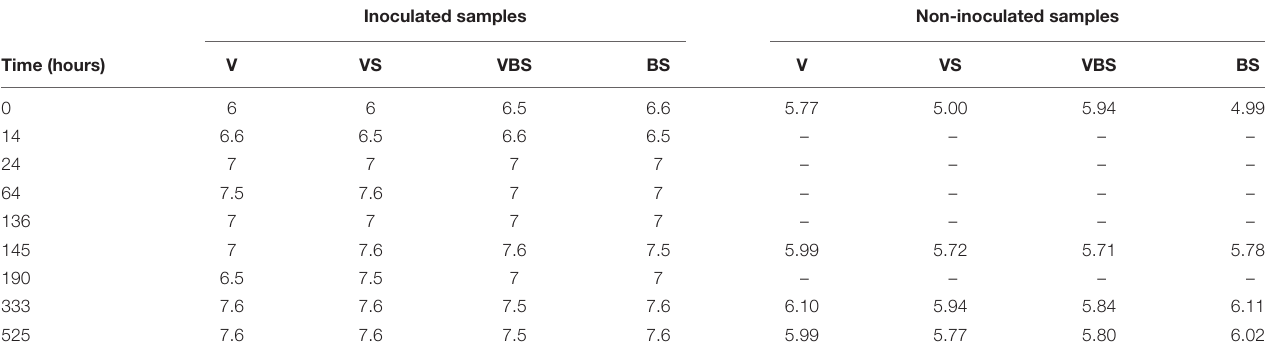
TABLE 6 | Evolution of the pH measured by pH indicator test strips, under the different conditions studied in table olives. Inoculated